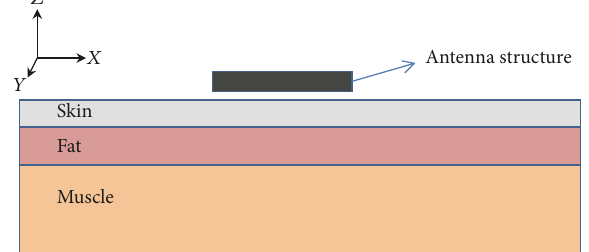
Figure 9: Effect of slots location on impedance bandwidth.